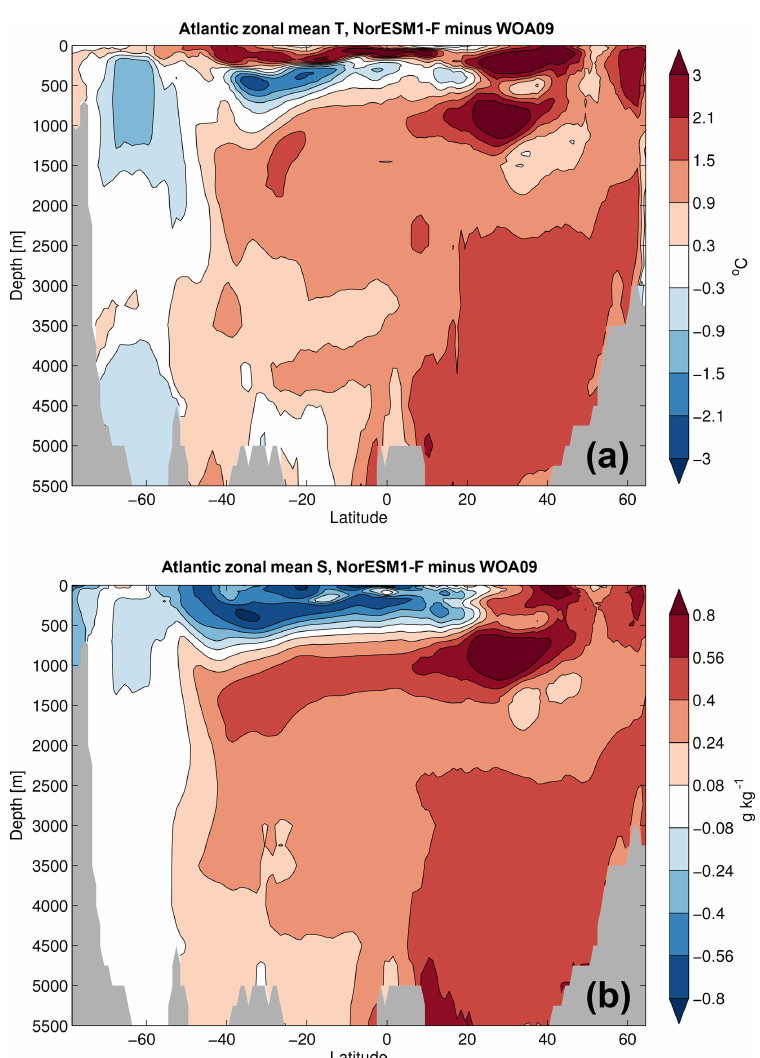
Figure 5. Simulated Atlantic zonal mean (a) potential temperature and (b) salinity biases (historical simulations minus WOA09 data; model results are averaged between 1976 and